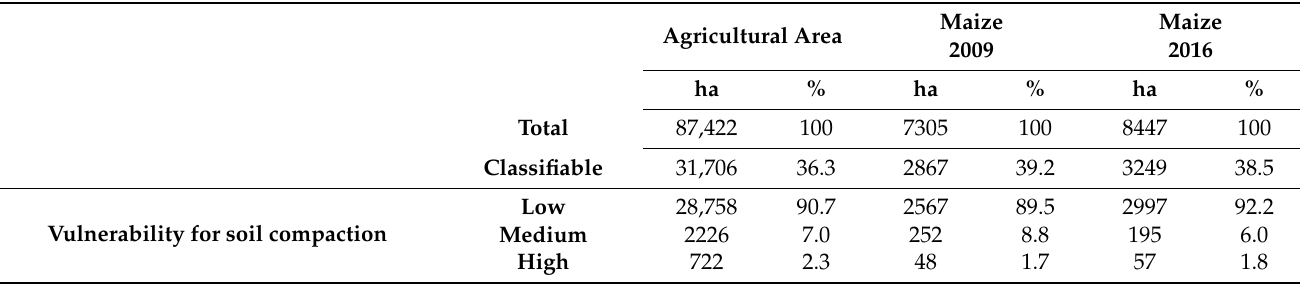
Figure 6. Representation of the susceptibility of the agricultural sites for soil compaction during harvesting action of silage maize. ‘Classification not possible’ refers to sites for which the soil profile descriptions showed apparent mistakes. When soil profile descriptions were not existing or not available in digital form, they were categorized as ‘No data available’. Areas shown in white colour are non-agricultural sites. Table 5. Parameters specifying the quality of the data basis for the soil type classification approach. Assignment of the agricultural area as well as maize cultivation in 2009 and 2016 to the classified susceptibility for soil